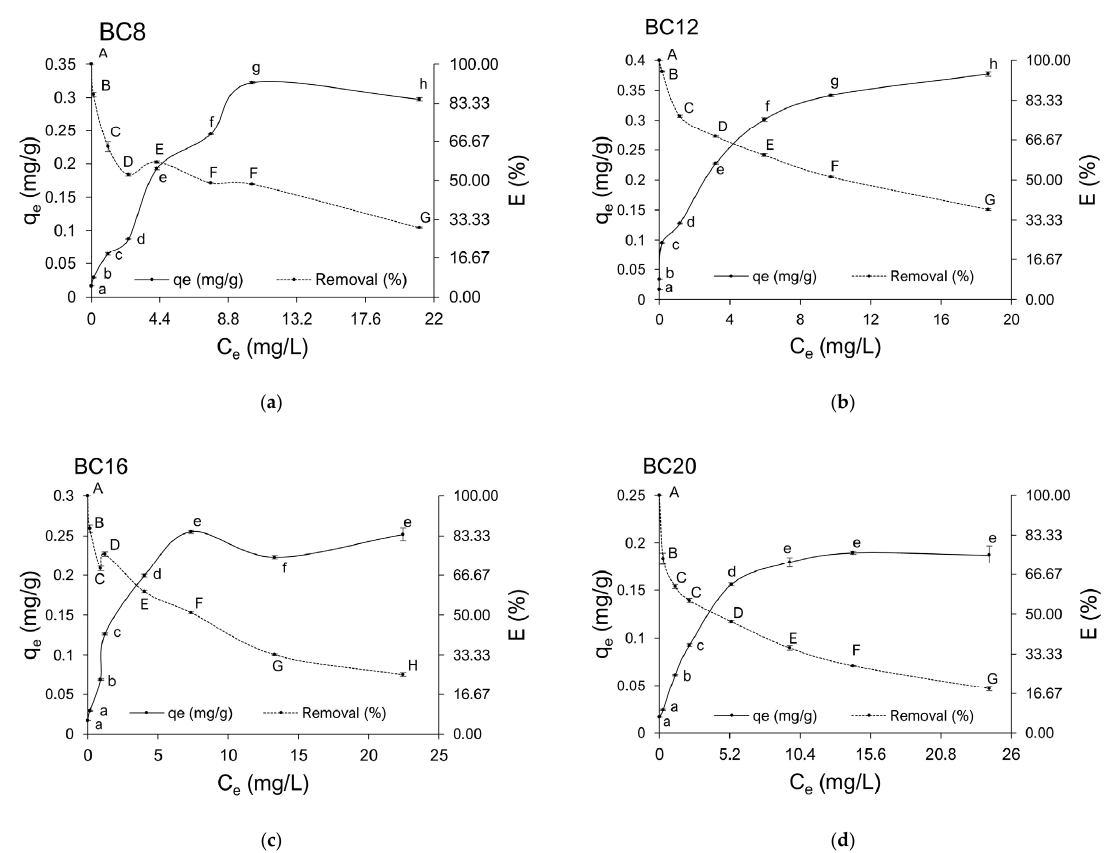
Figure 7. Removal efficiency (E) and experimental q e for: ( a ) BC8; ( b ) BC12; ( c ) BC16; ( d ) BC20. Uppercase and lowercase letters indicate significant differences among E and q e , respectively.